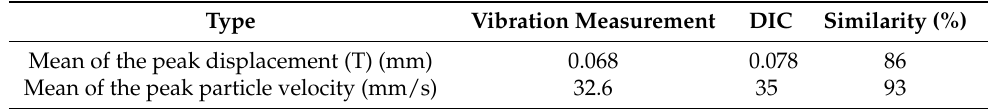
Table 4. Comparison of measurement results with the DIC